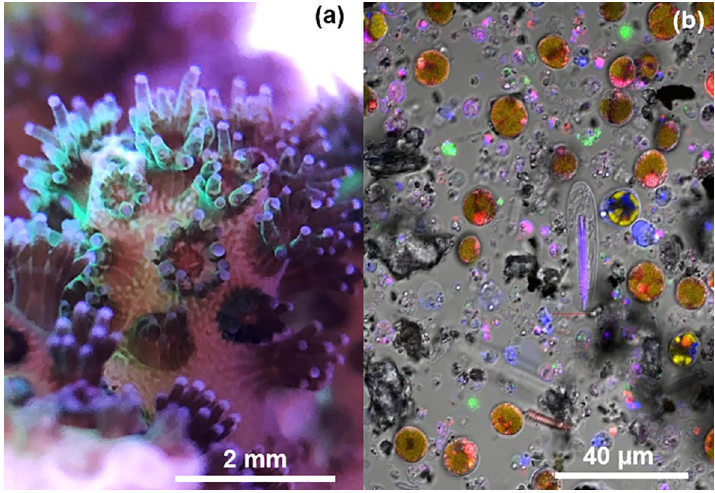
Figure 2. Photograph of Pocillopora damicornis in aquarium with polyps displaying the green fluorescent phenotype ( a ) and cells dissociated from P. damicornis stained with ReadyProbes cell viability imaging kit (red: propidium iodide for dead cells, blue: NucBlue for all cells) imaged under confocal laser scanning microscope (Zeiss LSM 710, VCU Microscopy Core) [other colors are as follows: yellow for chlorophyll fluorescence and green for endogenous GFP, DIC set for contrast on center cell] ( b ). The most recognizable cell types are the symbiotic dinoflagellates (golden-brown rounded cells, color generated from overlay of yellow and red) and